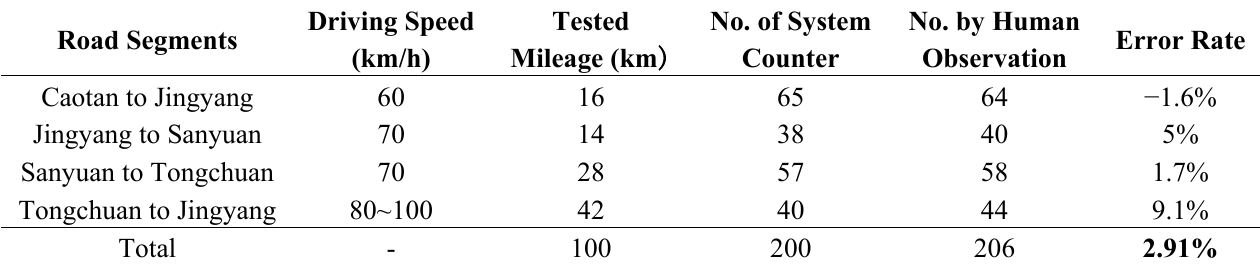
Table 3. Experimental results with signal strength on 13 July